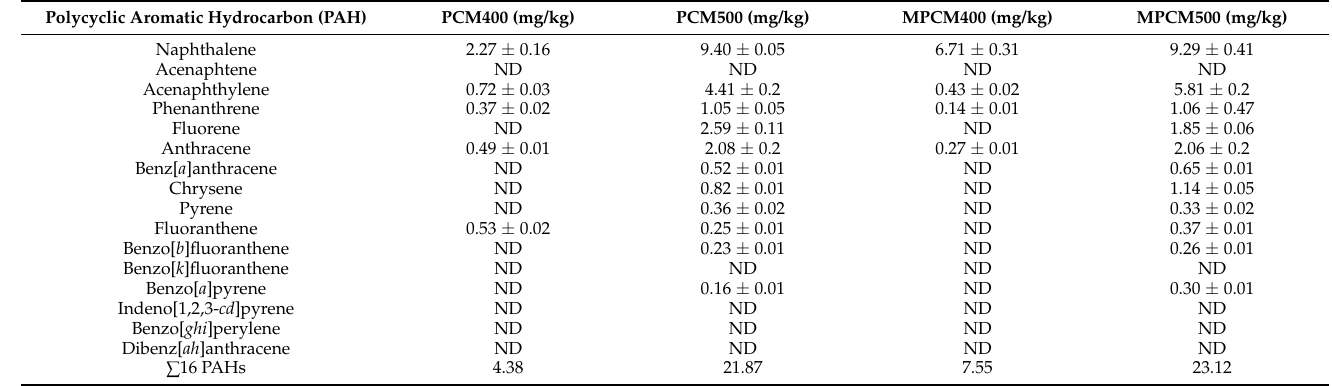
Total concentrations (mean ± SD) of naphthalene, acenaphtene, acenaphthy- lene, phenanthrene, fluorene, anthracene, benz[ a ]anthracene, chrysene, pyrene, fluoran- thene, benzo[ b ]fluoranthene, benzo[ k ]fluoranthene, benzo[ a ]pyrene, indeno[1,2,3- cd ]pyrene, benzo[ ghi ]perylene and dibenz[ ah ]anthracene in PCM400, PCM500, MPCM400 and MPCM500 deter-